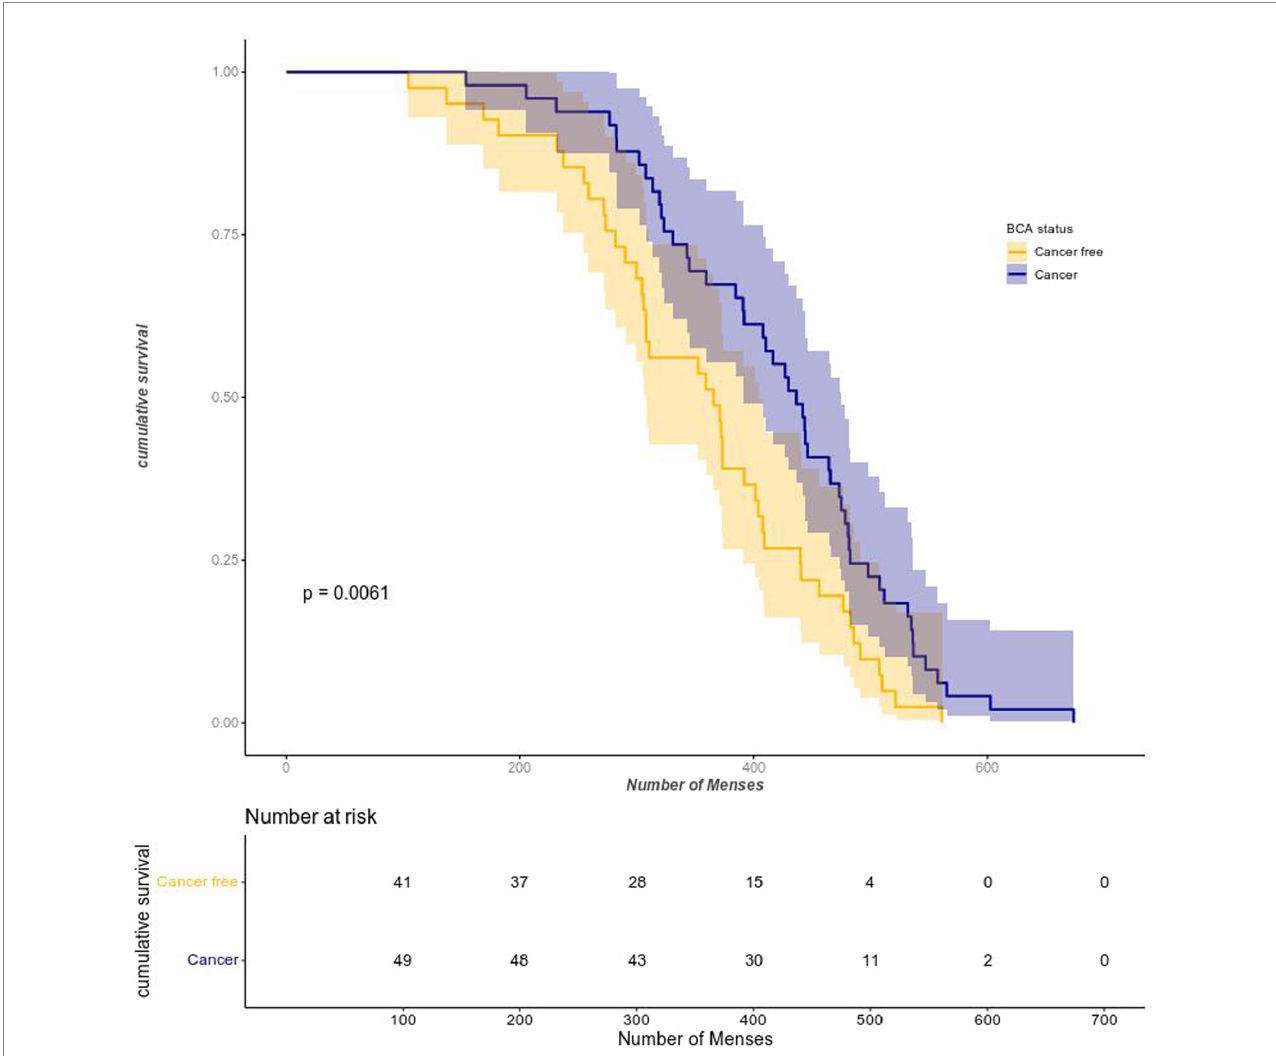
FIGURE 2 Survival as a function of the lifetime number of episodes. The Kaplan–Meier shows that without correcting for any cofactors, cancer patients experienced more lifetime menses than controls. Please note that the horizontal axis represents the lifetime number of menses, not chronological time. BCA status = Breast